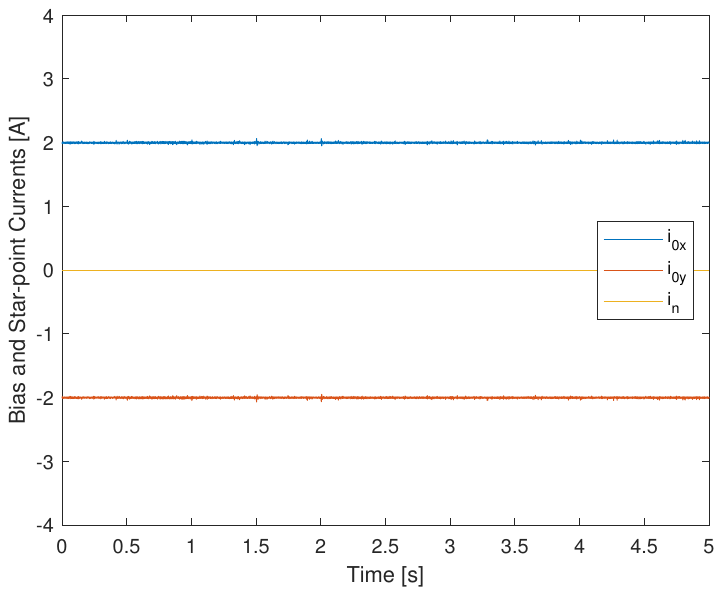
Figure 20. Measured bias and neutral current after anti-transformation.